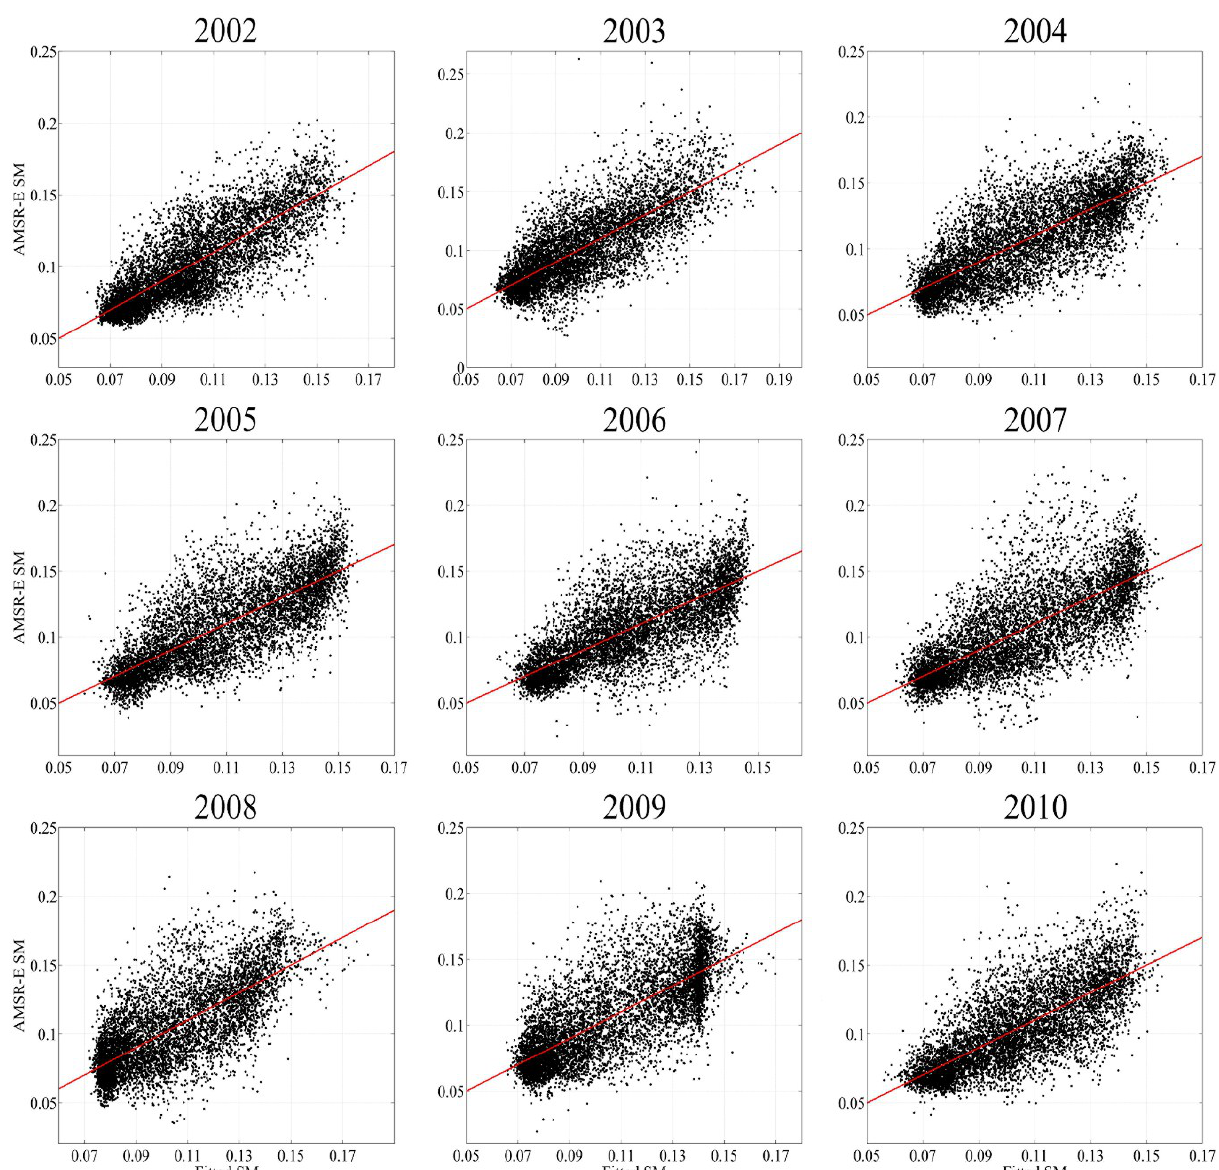
Figure 6. The scatterplots of the fitted SM versus the AMSR-E SM in August 2002–2010 in grassland regions and barren or sparsely vegetated regions in